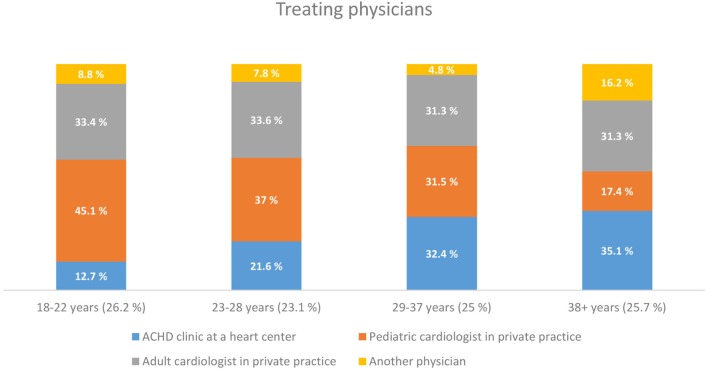
Treating physicians.